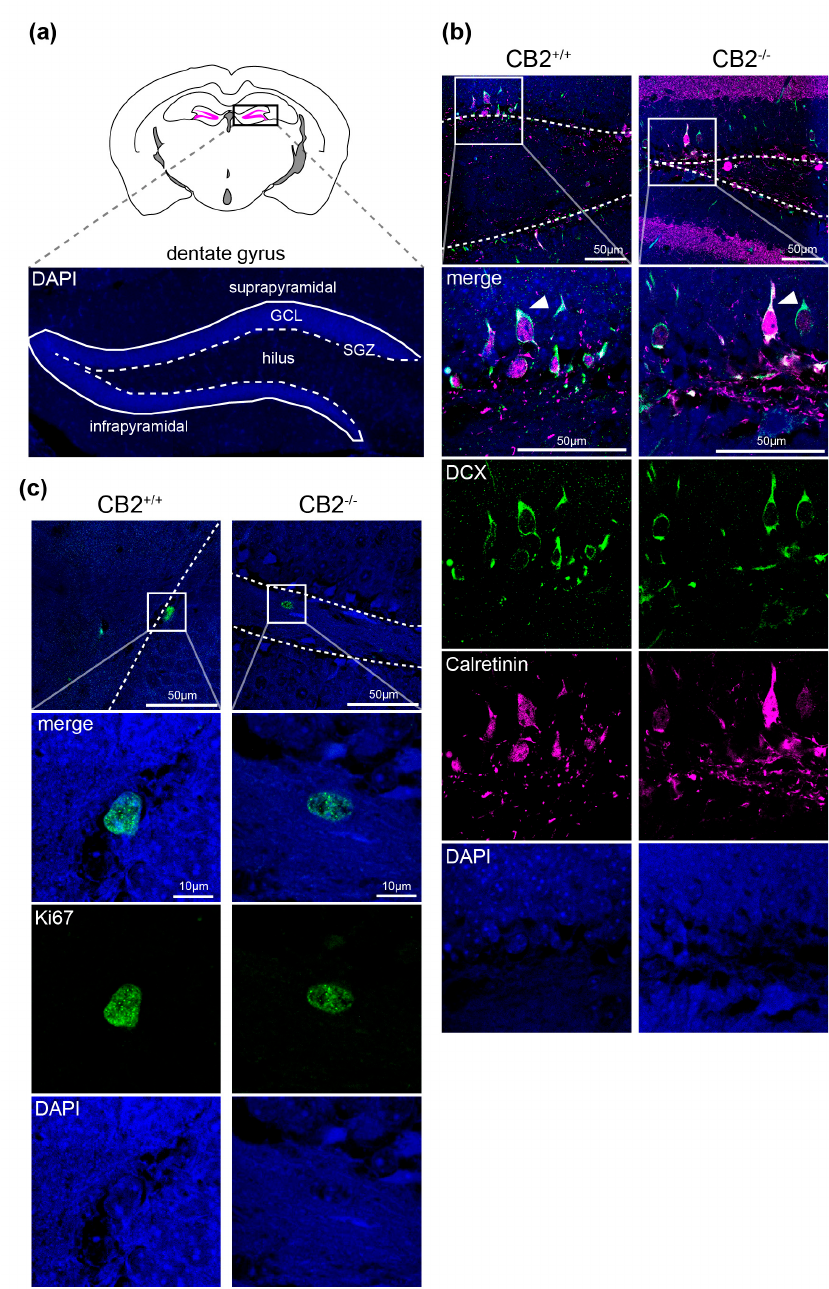
Figure 1. Representative confocal microscopy images of immunohistochemistry detection of Ki67, DCX (doublecortin) and CR (calretinin) in CB2 wildtype and knockout brain sections. ( a ) Overview of the mouse dentate gyrus (magenta in black rectangle) in the hippocampus and identification of relevant structures in a representative microscopy image of a brain section with DAPI-staining. ( b ) Merged fluorescent images of subgranular zone (SGZ) from both genotypes stained with DCX (green), calretinin (magenta) and DAPI (blue) are seen in the first row. The white rectangle shows the field of view that is shown in rows two to four in higher magnification. White arrowheads indicating the location of CR + DCX + cells, the asterisk shows a CR + inhibitory neuron in the hilus. ( c ) Merged fluorescent images of SGZ from both genotypes stained with Ki67 (green) and DAPI (blue) are seen in the first row. The white rectangle shows the field of view that is shown in rows two to three in higher magnification. The dotted line represents the SGZ. Template for scheme in ( a ) modified from The Scalable Brain Atlas [18,19].